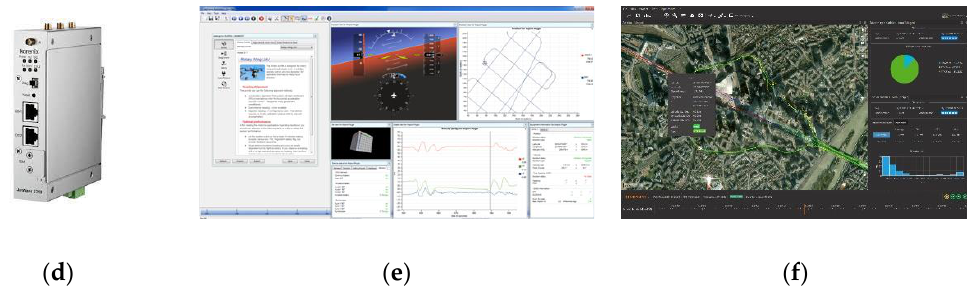
Figure 1. Components of the GNSS/INS system, model Ekinox2-U, by the SBG Systems: IMU ( a ),